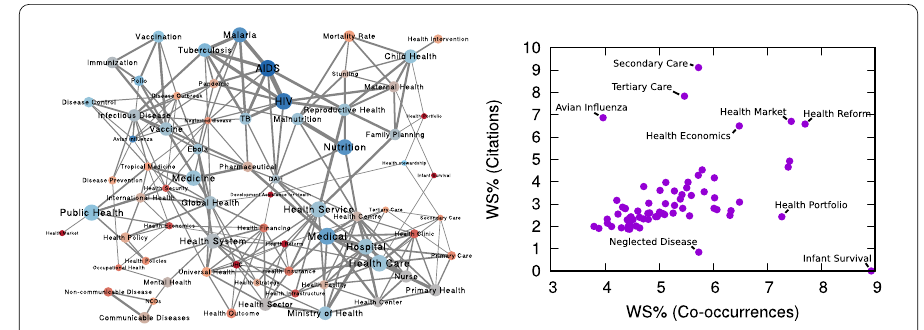
Table 3 The ten most associated issues to the World Bank according to WS Rank Keyword WS % 1 Infant Survival 8.93 2 Health Reform 7.71 3 Health Market 7.45 4 UHC 7.42 5 Development Assistance for Health 7.39 ... ... ... 66 Nutrition 4.05 67 Malaria 4.04 68 Avian influenza 3.97 69 HIV 3.89 70 AIDS